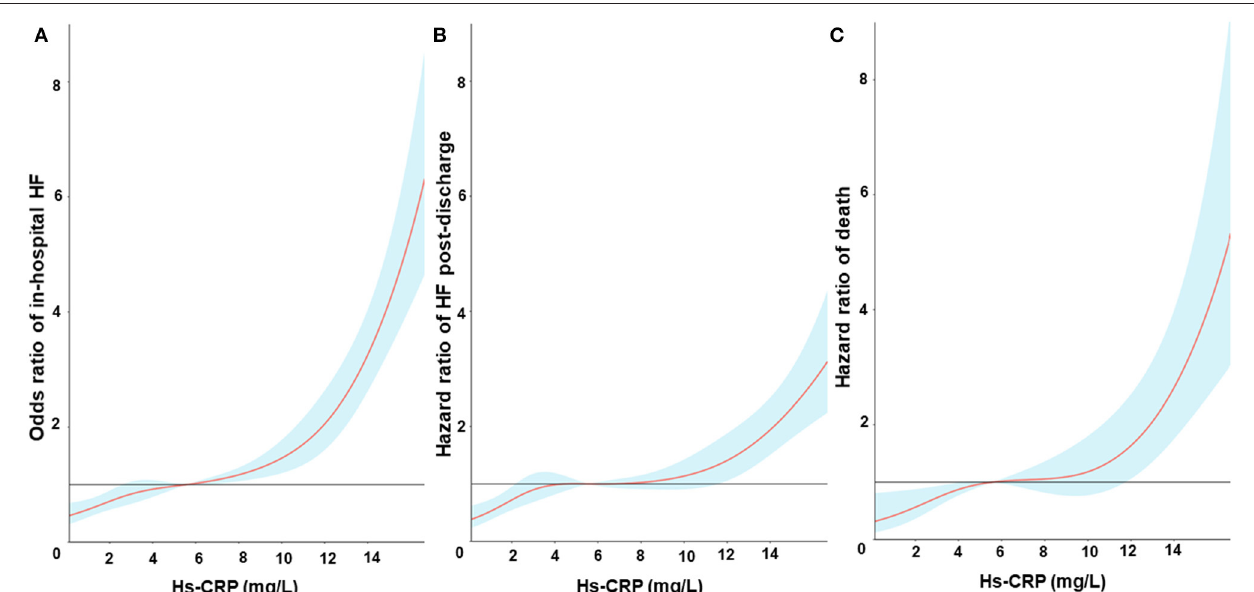
FIGURE 2 | Restricted cubic spline fitting for the association between hs-CRP levels and in-hospital heart failure (A) , heart failure post-discharge (B) and all-cause mortality (C) . Odds ratios or Hazards ratios were evaluated by setting the hs-CRP value = 6 mg/L as reference based on a univariate logistic regression or Cox proportional regression model. The shaded area represents the 95% confidence